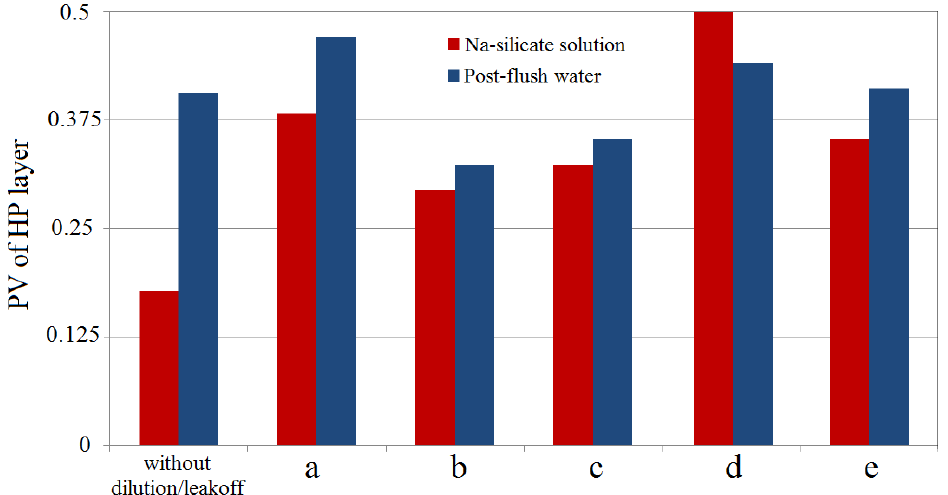
Figure 15. The required slug size of Na-silicate solution and post-flush water amount to place a 180 ft gel at the middle of the HP layer in the two-layered reservoir. The results are shown for different studied Cases (a–e), listed in Table 5. The first columns are devoted to the calculated values for a case without dilution and